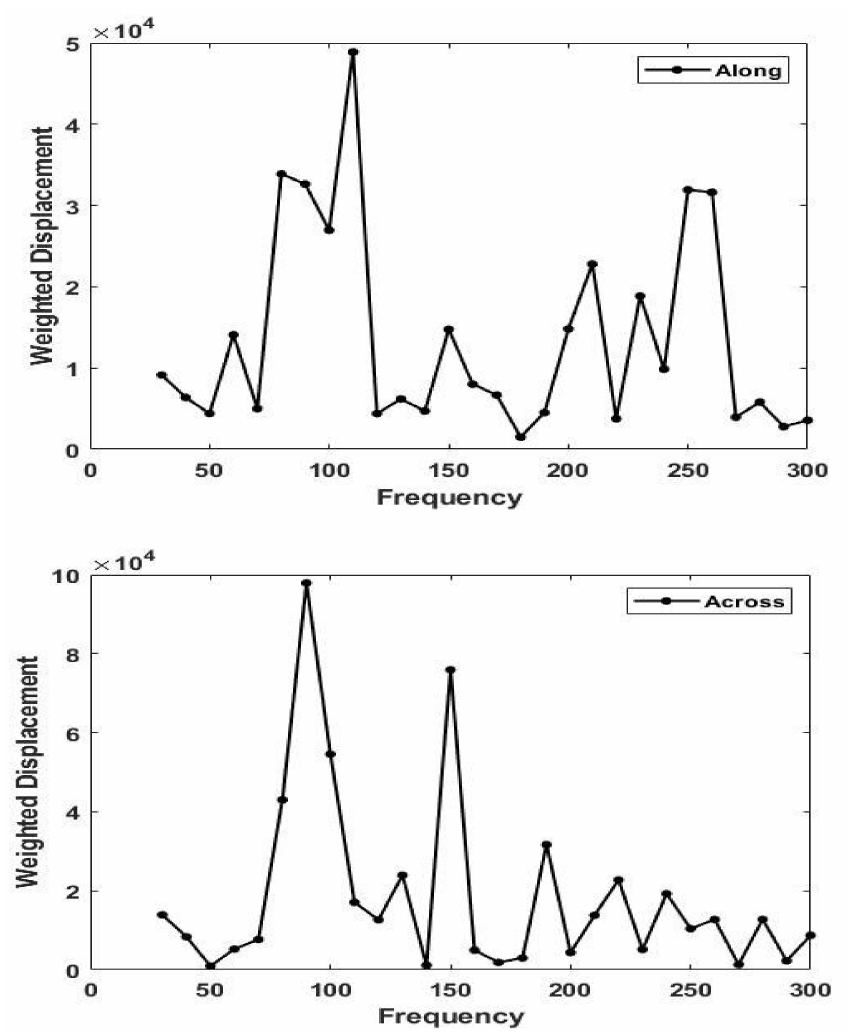
Figure 5. Plots of weighted displacement in µ m versus frequency in Hz parallel (0 ◦ ) to the orientation of the collagen fibers ( top ) and perpendicular (90 ◦ ) to the orientation of the collagen fibers ( bottom ) in skin in vivo at 5% strain. Note the shift in the dermal collagen peak from about 90 Hz (perpendicular) to 110 Hz (parallel). The modulus measured parallel to the collagen fibers is higher than that perpendicular to the fibers (see Equation